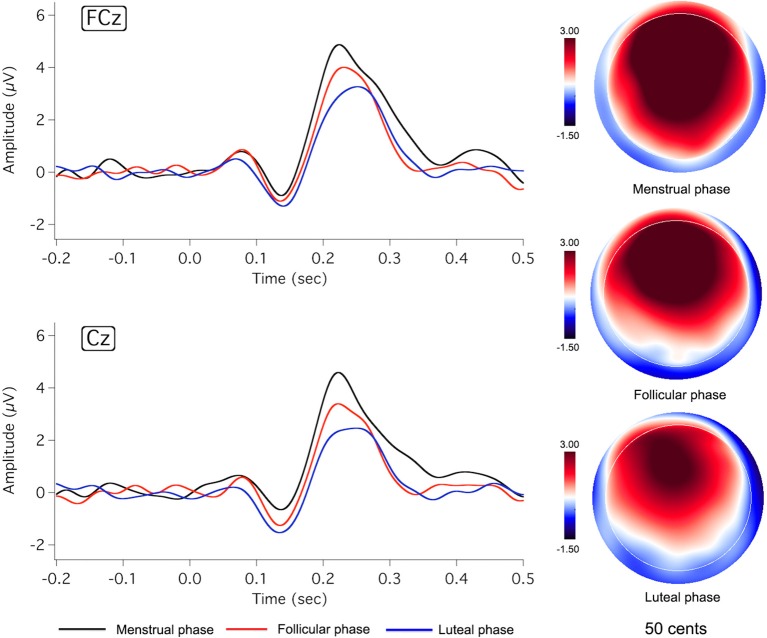
Grand-averaged ERP waveforms (left) in responses to pitch-shift stimuli of −50 cents during the menstrual (black lines), follicular (red lines), and luteal phases (blue lines), and topographic distributions of P2 amplitudes (right) during the menstrual (top: latency = 233 ms), follicular (middle: latency = 227 ms), and luteal phases (bottom: latency = 242 ms).